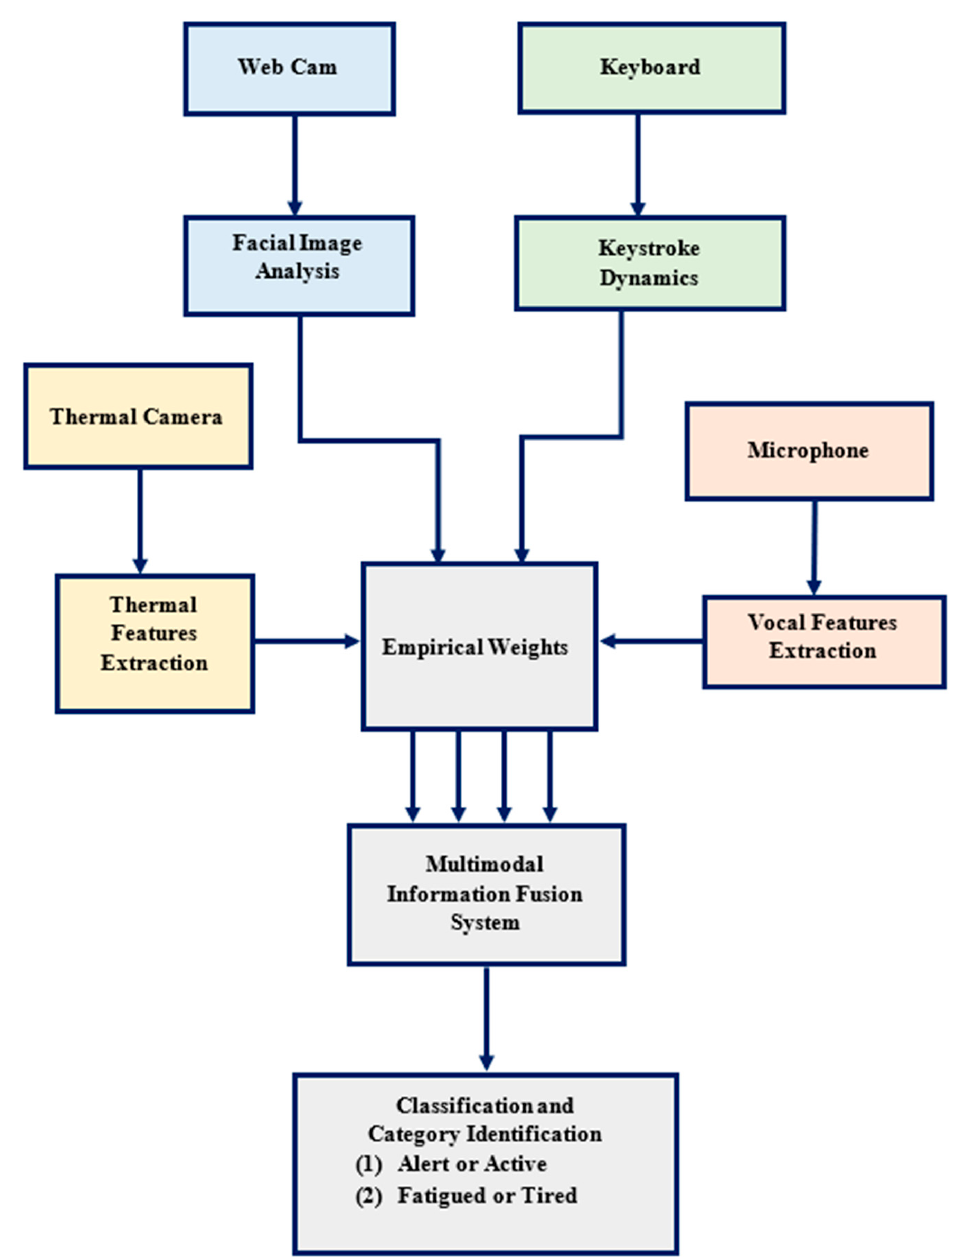
Figure 2. Exhibits methodology for fatigue detection using multimodal fusion.